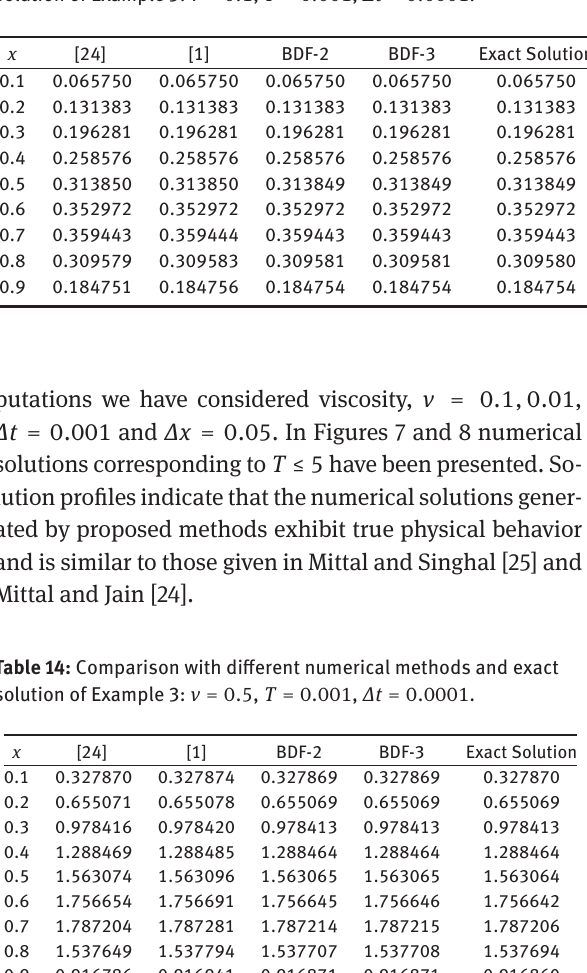
Table 13: Comparison with different numerical methods and exact